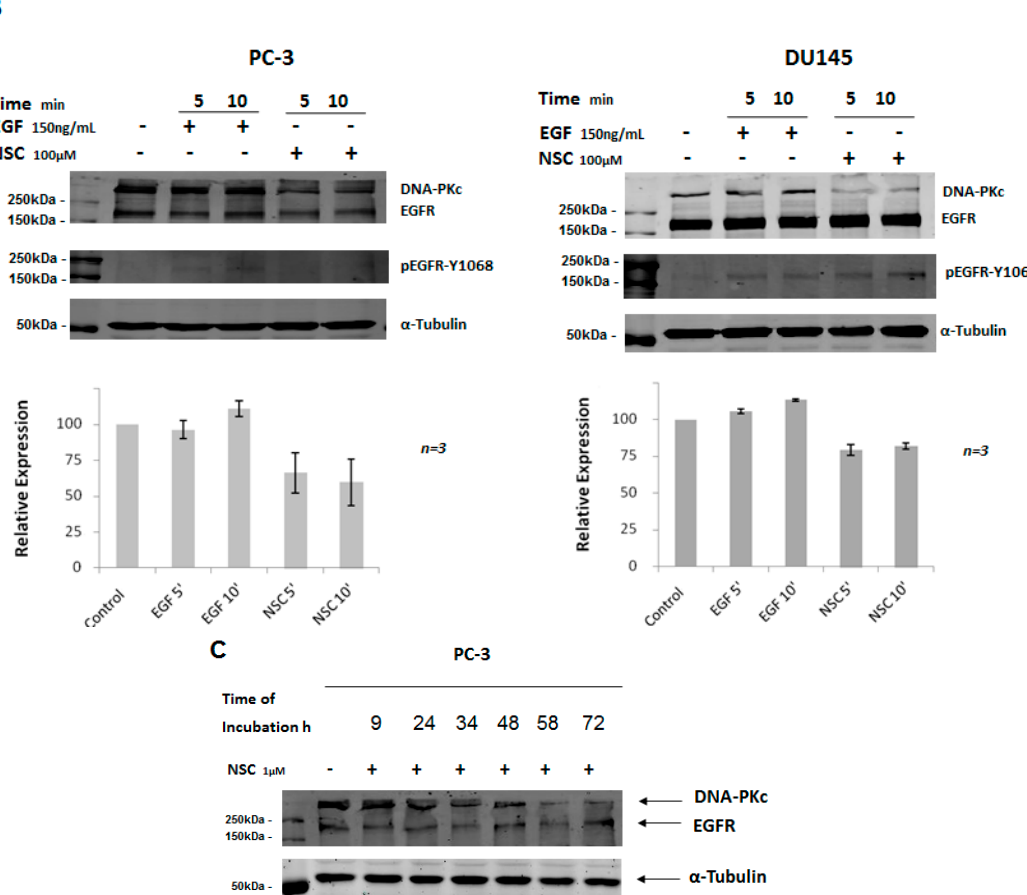
Figure 1. Relative level of DNA repair proteins in prostate cancer cells after exposure to compound NSC. ( A ) Levels of Rad51, PARP, MRE11, PCNA, EGFR, DNA-PKcs and KU DNA-binding subunits of DNA-PK were assessed in serum-starved PC-3 and DU145 cells, which were incubated with NSC (100 µ M), or EGF (150 ng/mL), or vehicle (DMSO) for 5 and 10 min; ( B ) Quantitative analysis of the fluorescent signal intensity of protein bands shows that the decrease in the amount of DNA-PKcs is more pronounced in PC-3 than in DU145 cells briefly exposed to NSC; ( C ) Longer exposure of PC-3 cells to low concentrations of NSC (1 µ M in this assay) also caused a gradual decrease in the DNA-PKcs expression level, but had almost no effect on the expression of EGFR in these conditions.